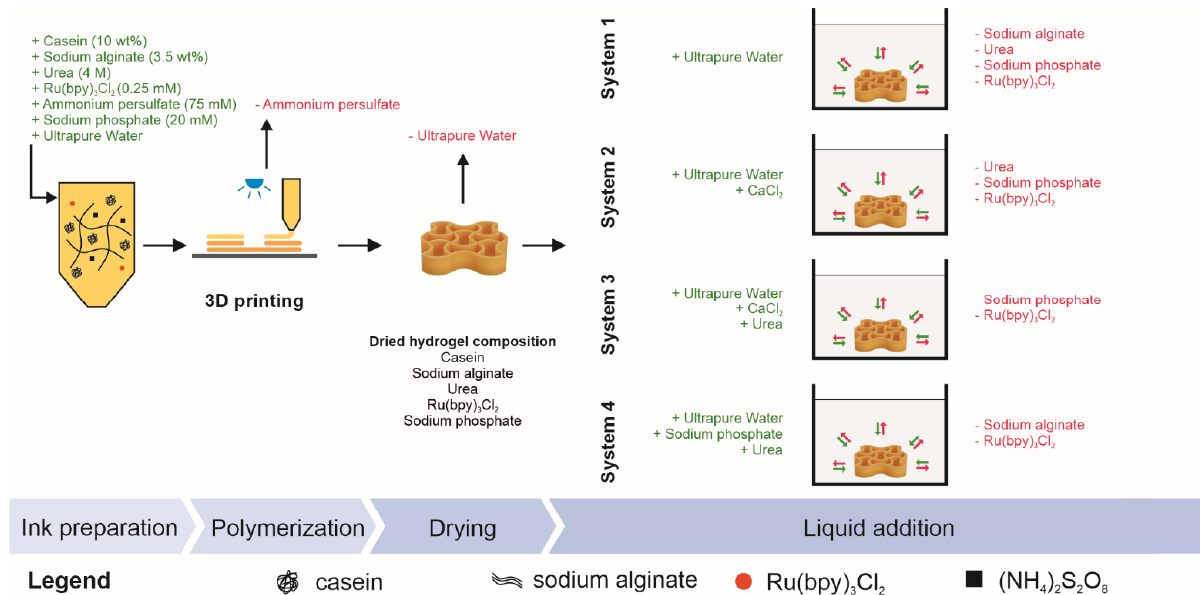
Figure 6. Overview of the chemical substances present in the hydrogel specimens during sample preparation and as a function of the immersion liquid system. Components added to the system (as part of the ink formulation or the different liquid systems used to rehydrate the auxetic structure) are marked in green, whereas components that might be diluted out of the hydrogel specimens are marked in red.